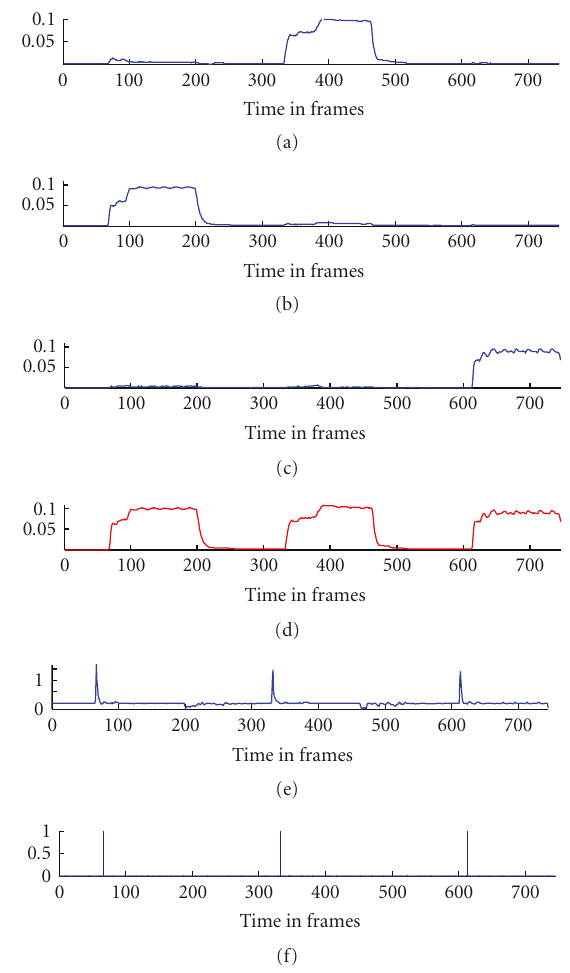
Figure 3: Detection results of the signal depicted in Figure 2.